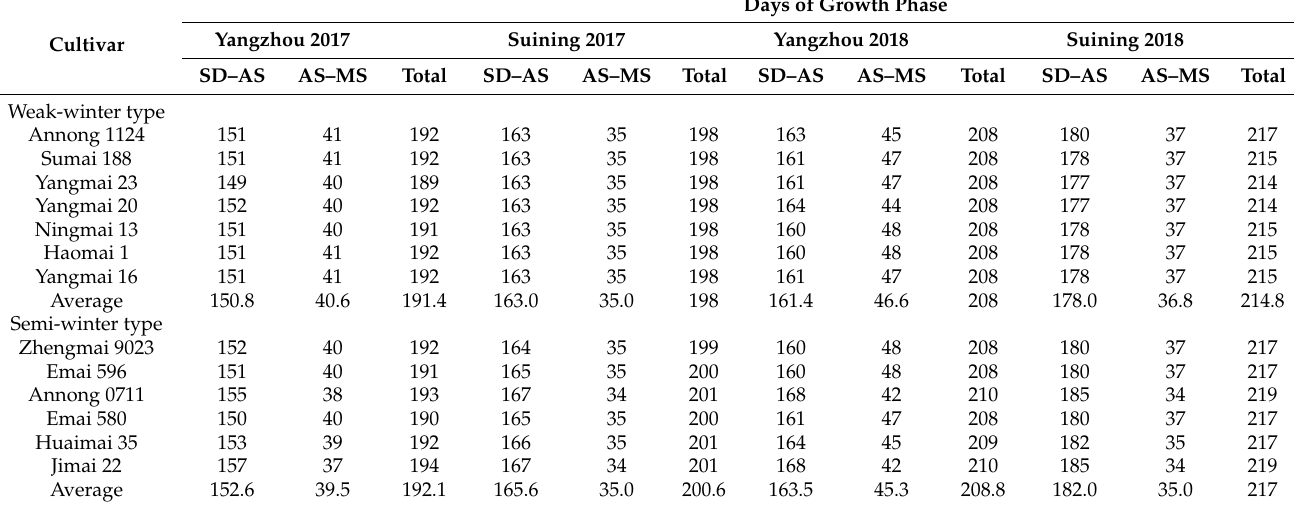
Table 2. Days in growth phases from sowing (SD) to anthesis (AS), anthesis to maturity (MS), and total phases of weak-winter-type and semi-winter-type cultivars planted in southern (Yangzhou) and northern (Suining) areas of the Yangtze River basin, China, in 2017 and